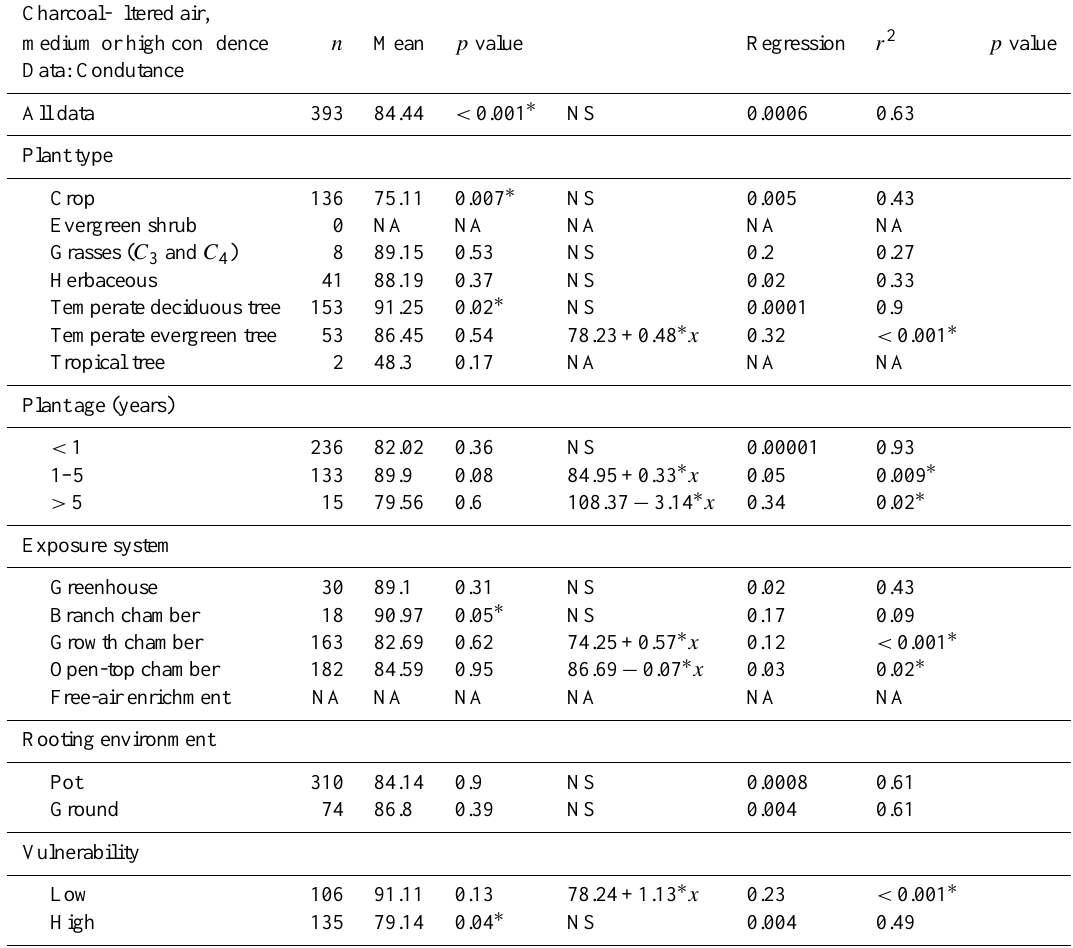
Table 3. The number of data points ( n ), mean, regression, and statistics for stomatal conductance when sorted by categories of plant type, plant age, O 3 exposure system, rooting environment, and vulnerability for all data that is compared to control plants exposed to charcoal- filtered air with medium or high confidence in cumulative O 3 uptake (CUO) calculations. All means are reported as the percent of control treatment. The p value for the overall data set (All data) designates whether the overall mean is significantly different from 100 (i.e., 0% change). The p value for the mean within each category designates whether the mean of the category is statistically different from the mean of the overall data set (All data). All regressions are based on the correlation of stomatal conductance to CUO for data within the category and are not included if the relationship is not significant (NS). The r 2 is calculated for each regression, and p values designate whether the relationship between stomatal conductance and CUO for data within the category is statistically significant. P values are considered significant at p =0.05, and significant values are indicated with ∗